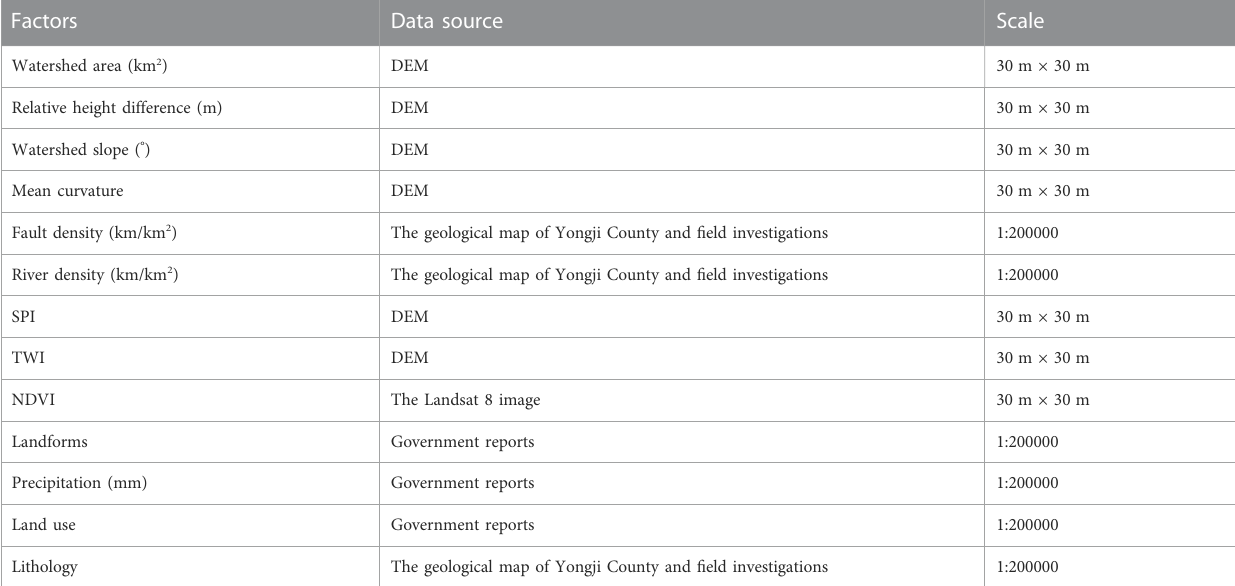
TABLE 2 Date source and scale of in fl uencing